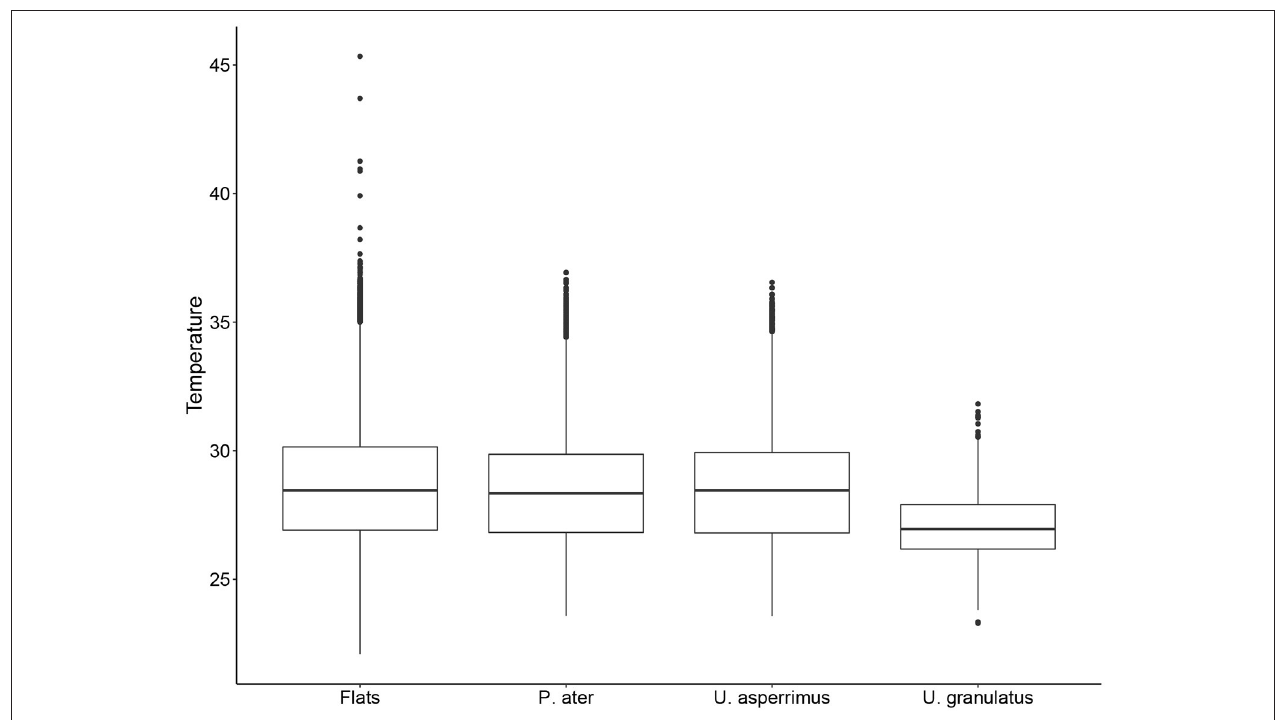
FIGURE 5 | Boxplot of mean hourly water temperatures ( o C) on the flats of St. Joseph Atoll, and the water temperatures on the flats when P. ater , U. asperrimus , and U. granulatus were present on the